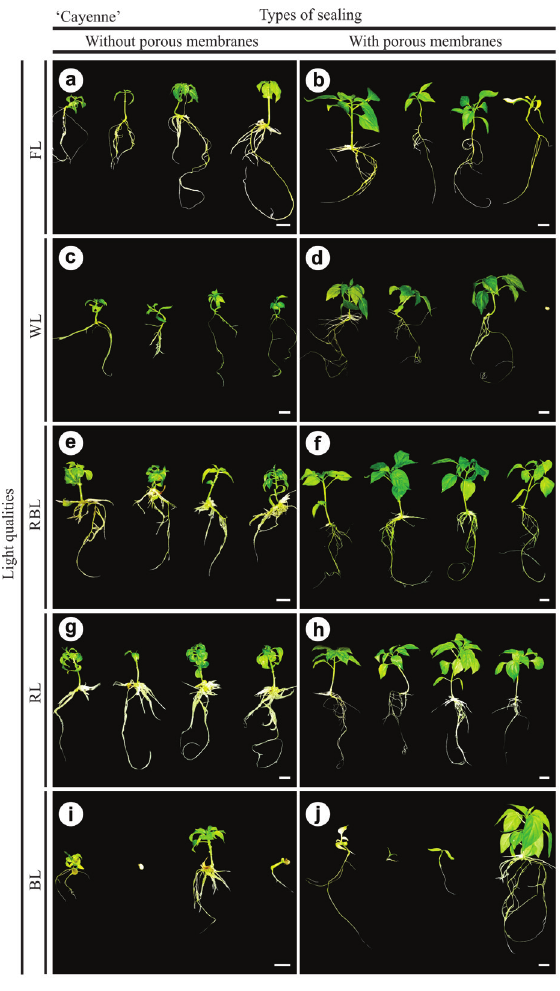
Figure 3. Plants of Capsicum frutescens cv. ‘Cayenne’ cultivated in vitro under different light qualities and types of sealing: Fluorescent (FL) without (a) and with porous membranes (b) ; White LED (WL) without (c) and with porous membranes (d) ; Red/blue LED (RBL) without (e) and with porous membranes (f) ; Blue LED (BL) without (g) and with porous membranes (h) ; Red LED (RL) without (i) and with porous membranes (j) . Bars: 1